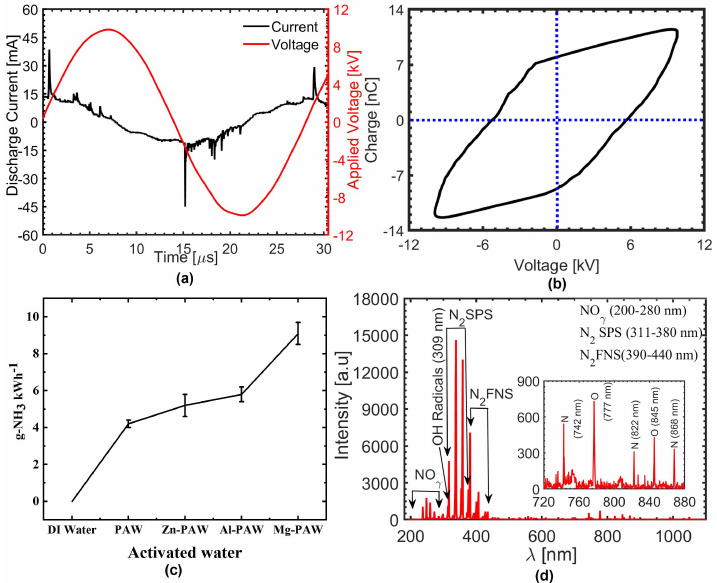
Figure 2. ( a ) Typical current and voltage waveforms of the plasma discharge. ( b ) Corresponding Q–V Lissajous figure. ( c ) The energy consumption for ammonia synthesis with various metal immersed in water. ( d ) Optical emission spectroscopy (OES) results for the nitrogen plasma measured at a position 3 mm downstream of the nozzle of the quartz tube. Applied voltage, 10 kV; Frequency, 33 kHz; Working gas,